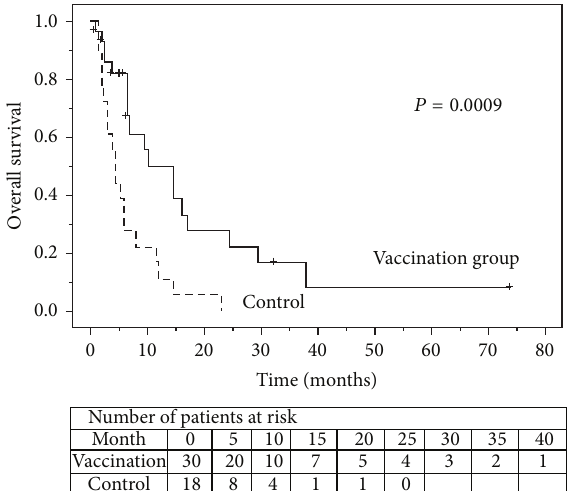
Figure 4: Kaplan-Meier estimated overall survival (OS) is shown for patients who received survivin-2B80–88 peptide vaccination with and without IFN alpha and did not receive survivin-2B80–88 peptide vaccination. A statistically significant difference in OS was identified between the two